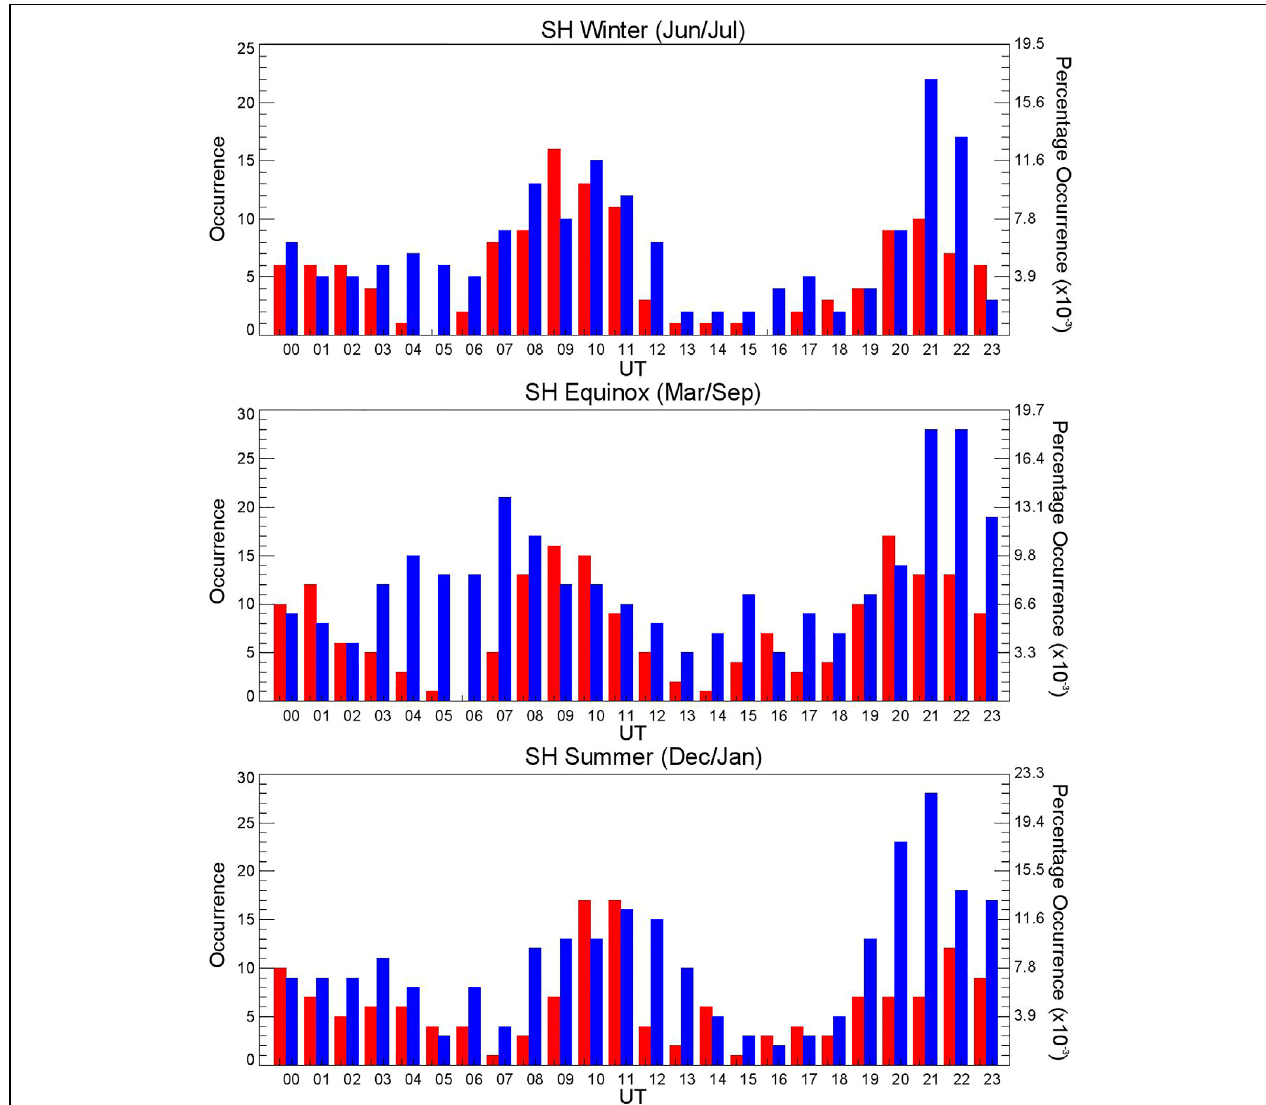
FIGURE 5 | The UT occurrence distribution of R2Bs from 2011 to 2014, for the southern hemisphere split by season: (top) southern winter (June/July) (middle) southern equinox (March/September), and (bottom) southern summer (December/January). The right-hand axis shows the percentage occurrence. Red showing dawn and blue showing dusk